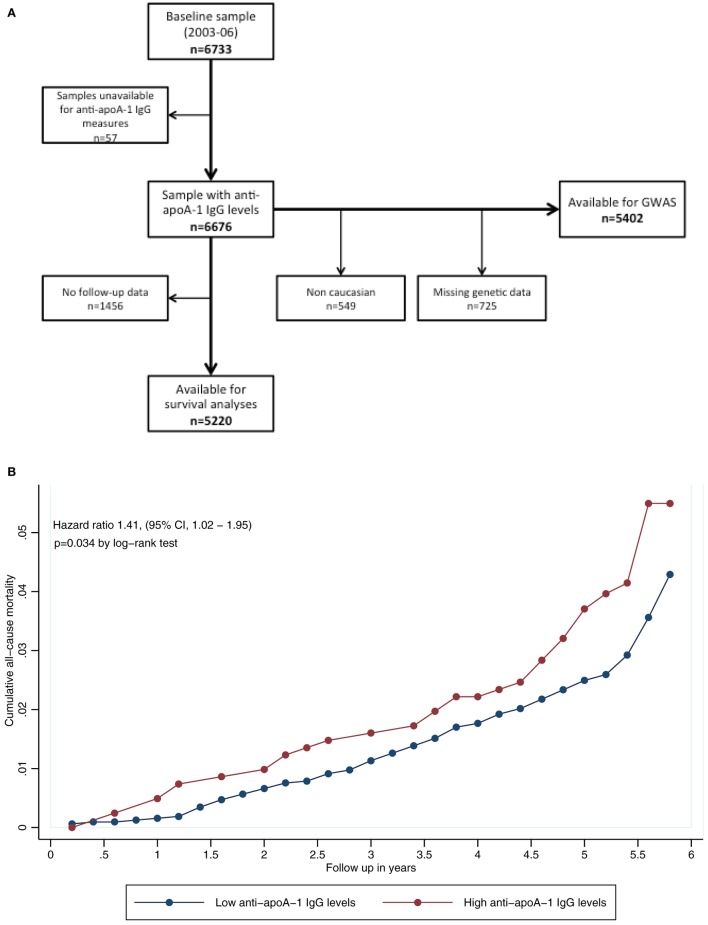
(A) Participants’ selection procedure. (B) Kaplan–Meier curves for all-cause mortality, according to autoantibodies against apolipoprotein A-1 (anti-apoA-1 IgG) status. P-value according to log-rank test (P = 0.034).